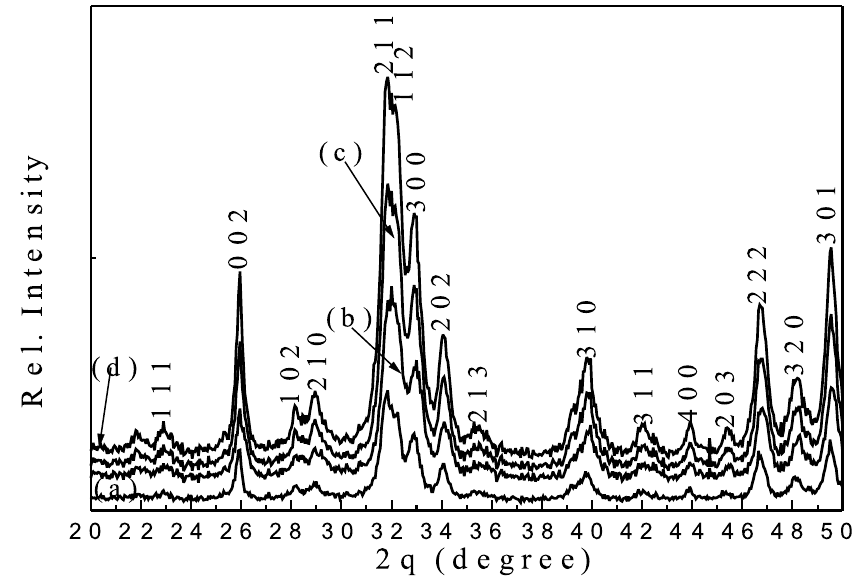
Fig. 2 – XRD patterns of powders (a) composite V, (b) composite II, (c) HAp100, and (d)